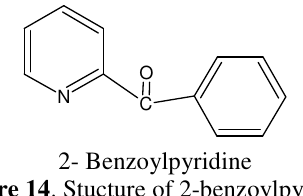
Figure 14 . Stucture of